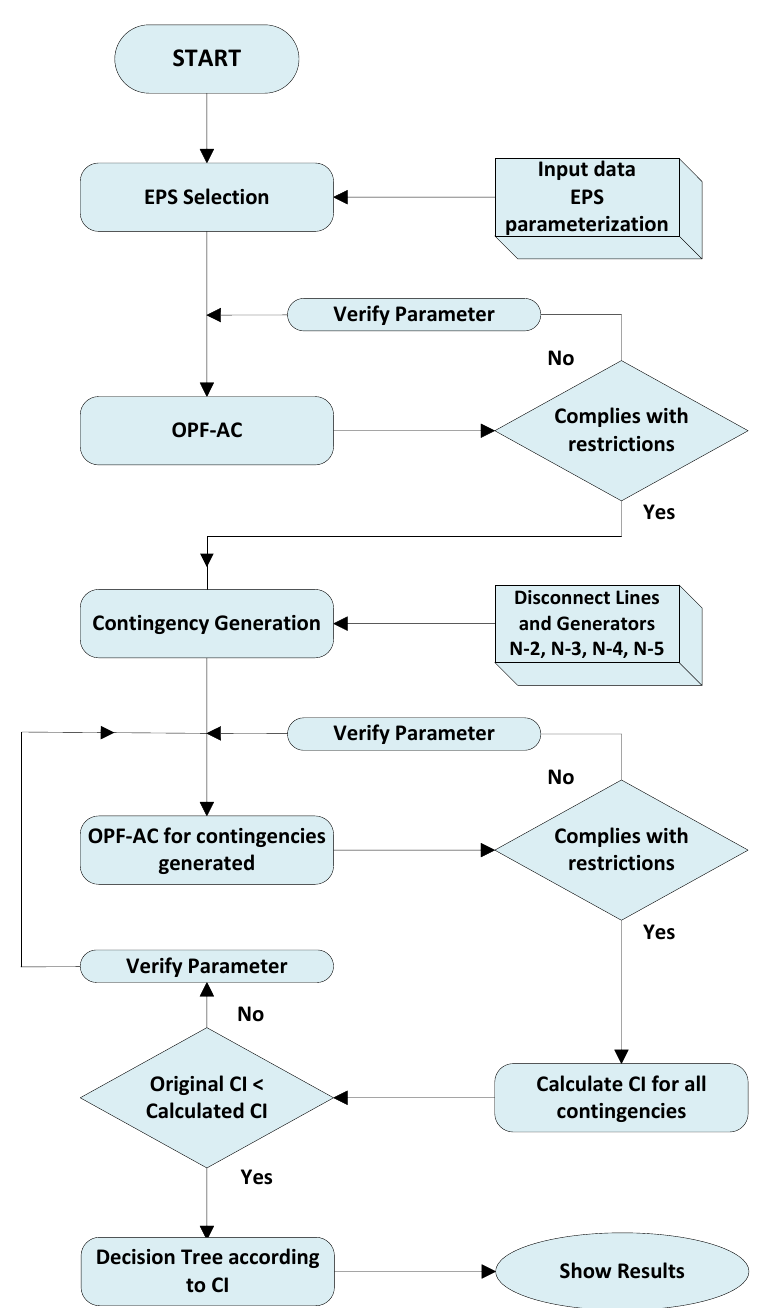
Figure 3. Solution methodology for the optimal restoration of